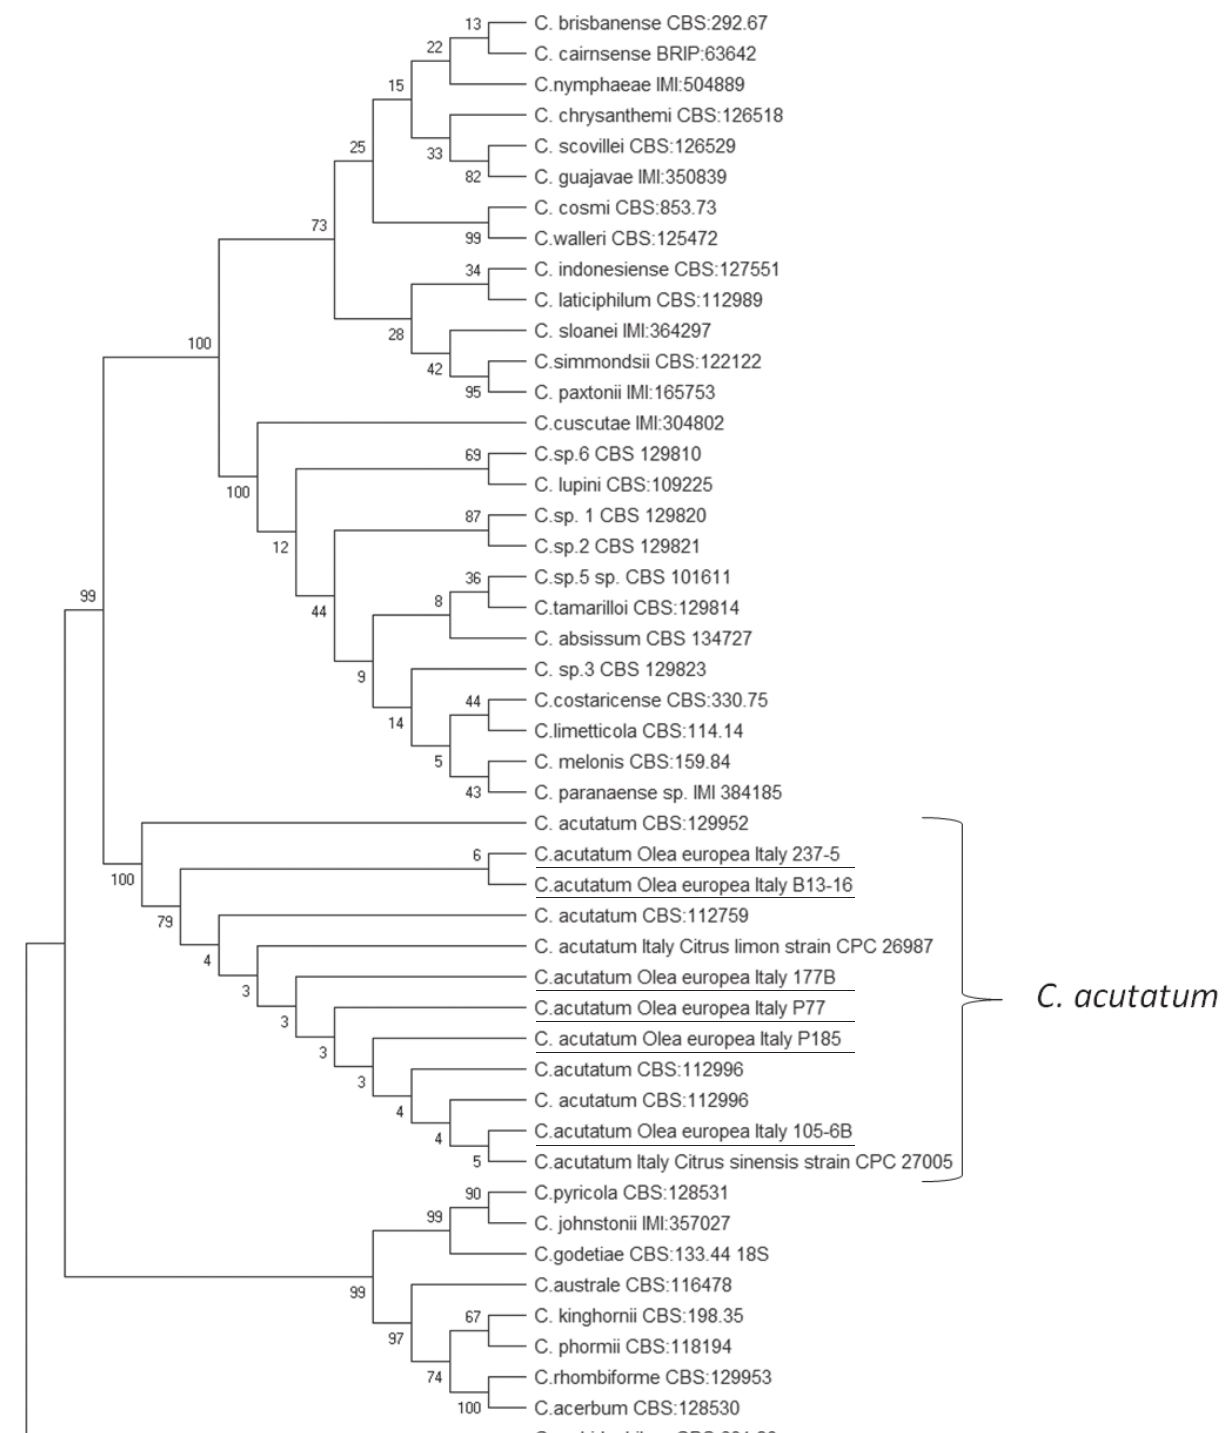
Figure 3. Phylogenetic analysis of the 47 Colletotrichum acutatum species complex strains listed in Supplementary Table S1, based on a multilocus concatenated alignment of the ITS, GAPDH, ACT, and TUB2 genes. The evolutionary history was inferred using the Maximum Parsimony method. Colletotrichum orchidophilum CBS 632.80 was used as an outgroup. The percentage of replicate trees in which the asso- ciated taxa clustered together in the bootstrap test (1000 replicates) are shown next to the branches. Strains described for the first time in this study are underlined. For strains originating from Italy, the hosts are